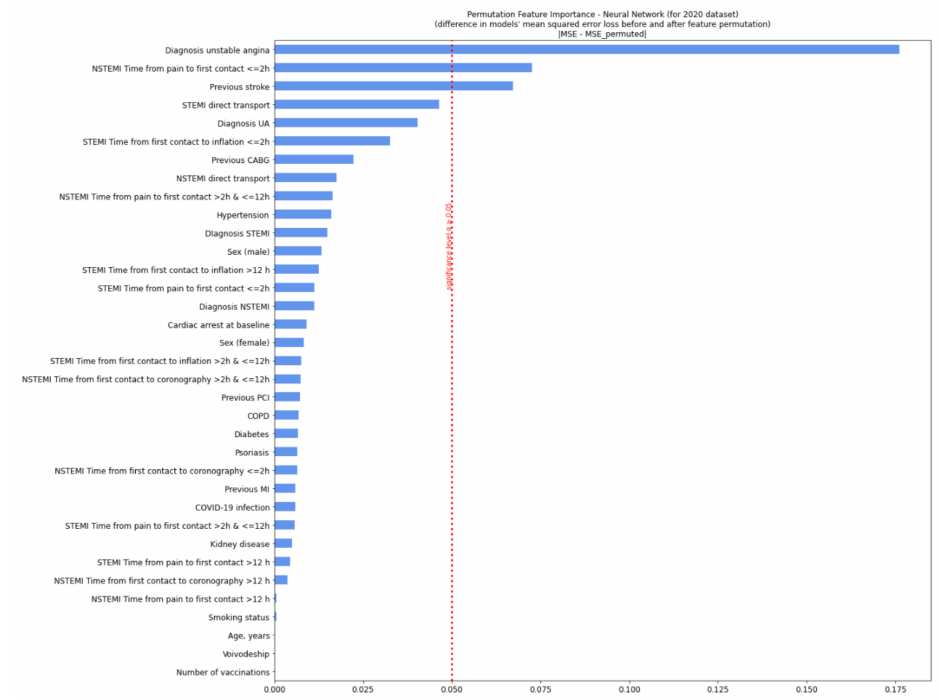
Figure 2. Permutation feature importance analysis for patients in 2020. The diagram shows a